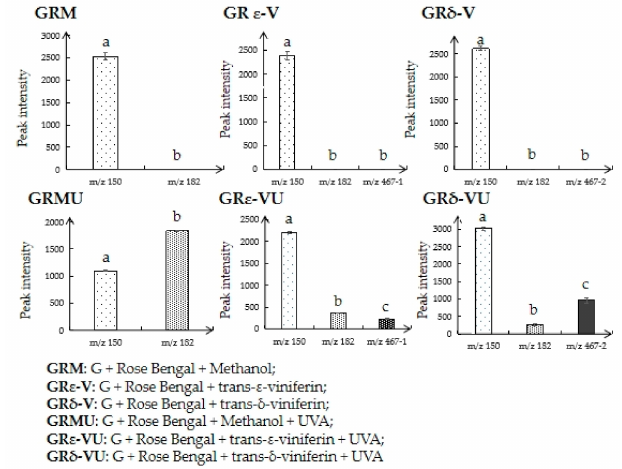
Figure 6. Quantitative results of target compounds in different treated groups. (Different letters indicate significant differences, i.e., a is significantly different to b or c, while data with the same letter, i.e., b vs. b, do not have significant